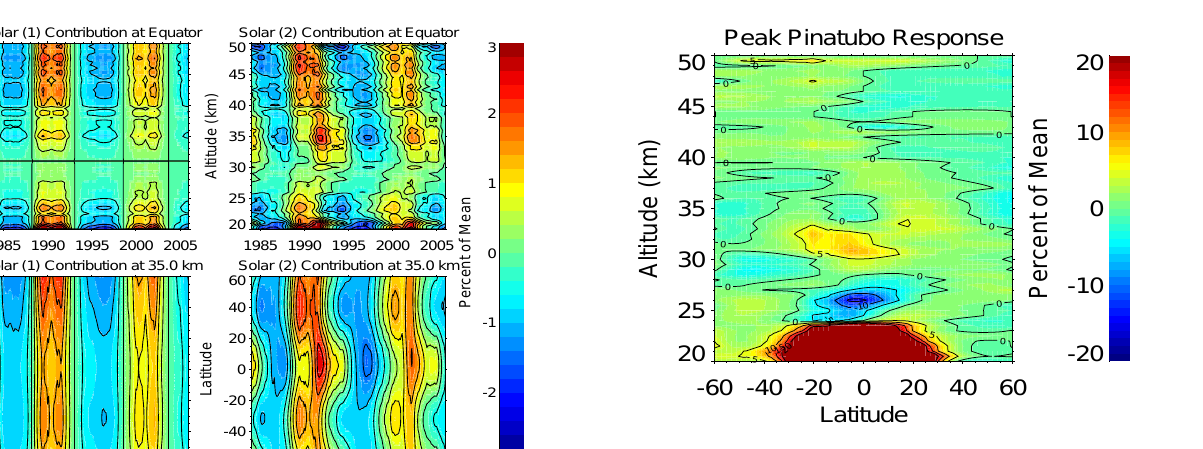
Figure 10. Peak of volcanic term near the time of Pinatubo as a percentage of mean. Anomalously high values at lower altitudes are the result of overfitting to gaps in data as shown in Fig. 3. Figure 9. Examples of the solar term for the use of one and two solar proxy terms while including a volcanic term. Contour lines are plotted at intervals of 0.5%.